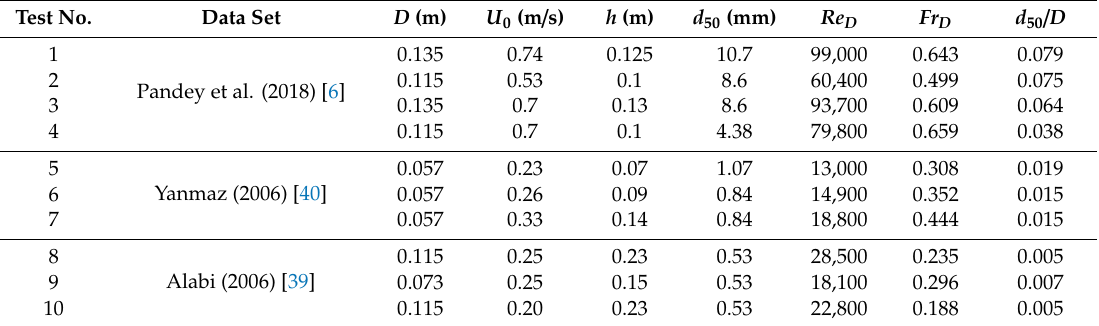
Table 1. Summary of experimental data and parameters used for current model